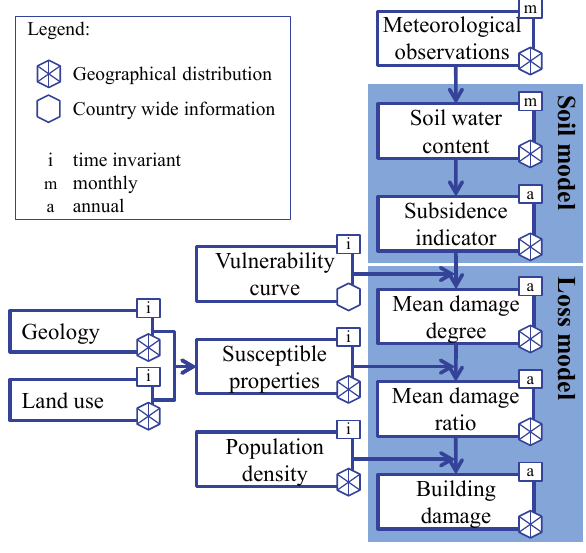
Fig. 2. Model outline for simulating damage from drought-induced soil subsidence. Using data from the individual insurers, upscaling of the whole French market results in damage 135